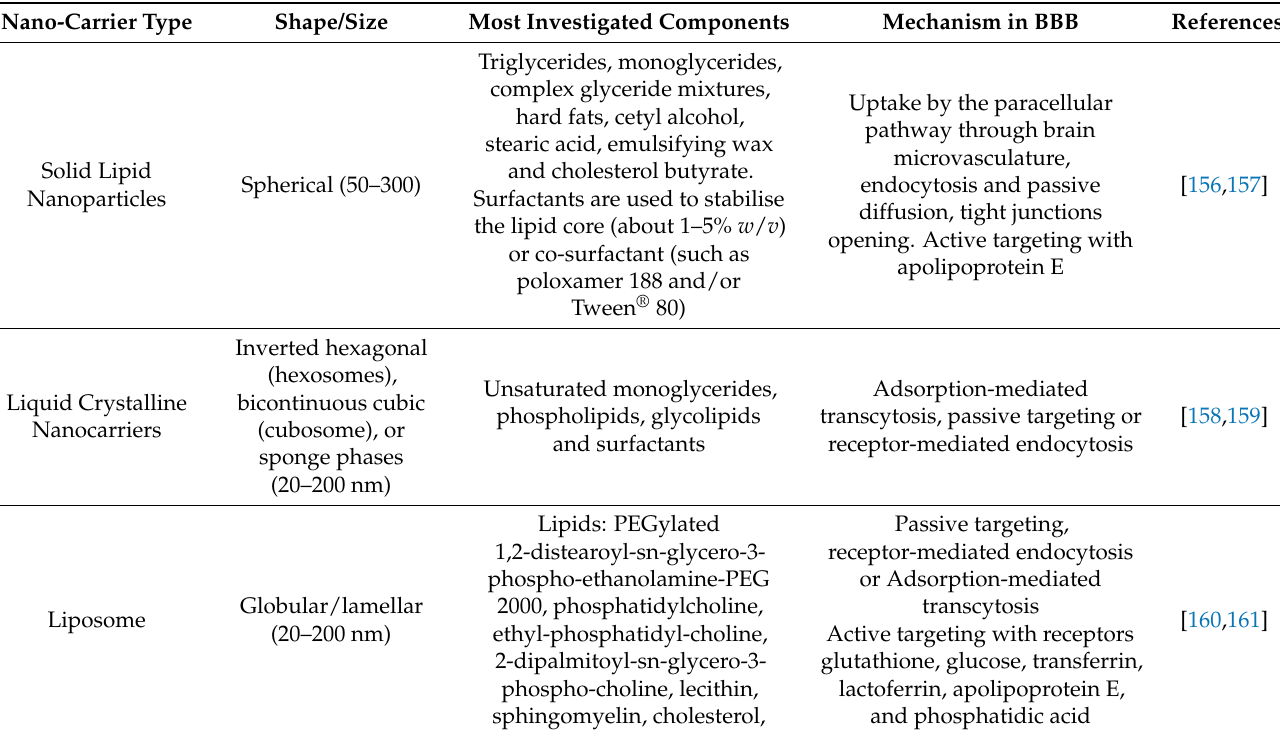
Table 3. Characteristic and the transport mechanism of the main curcumin-conjugated nanocarriers for BBB. Nano-Carrier